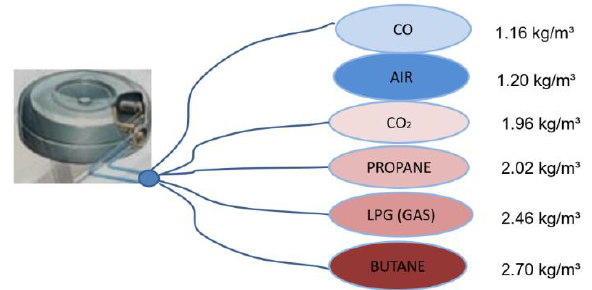
Figure 1. Liquified petroleum gas (LPG) gas density compared to other gases.